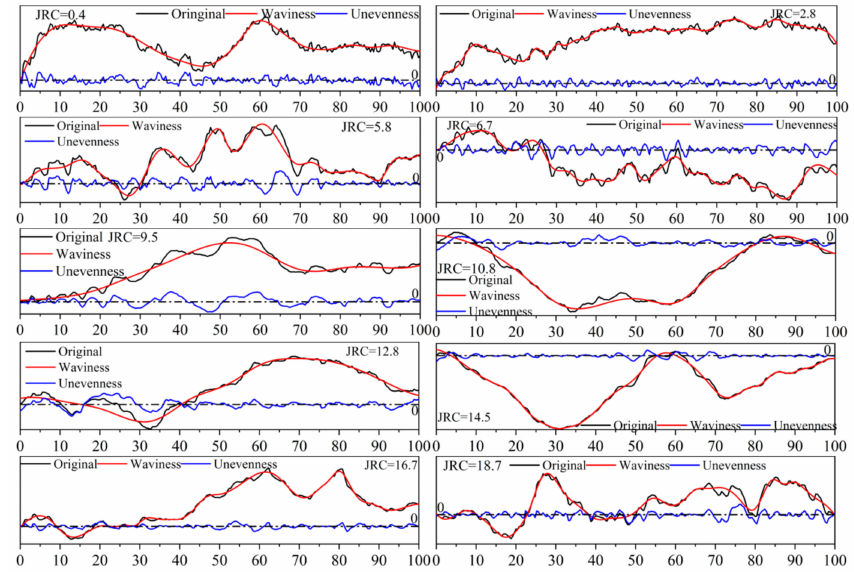
Figure 6. Decomposition results of the standard JRC